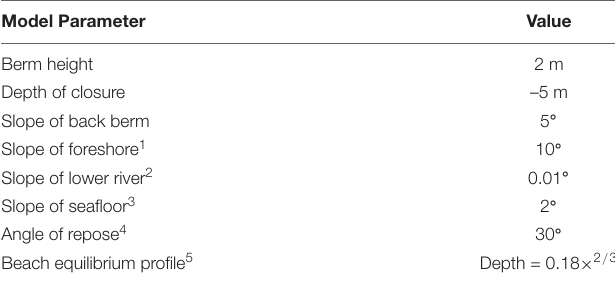
TABLE 2 | Parameters for a simple rules-based morphodynamic model to evaluate the effect of cross-shore transport directions. Model